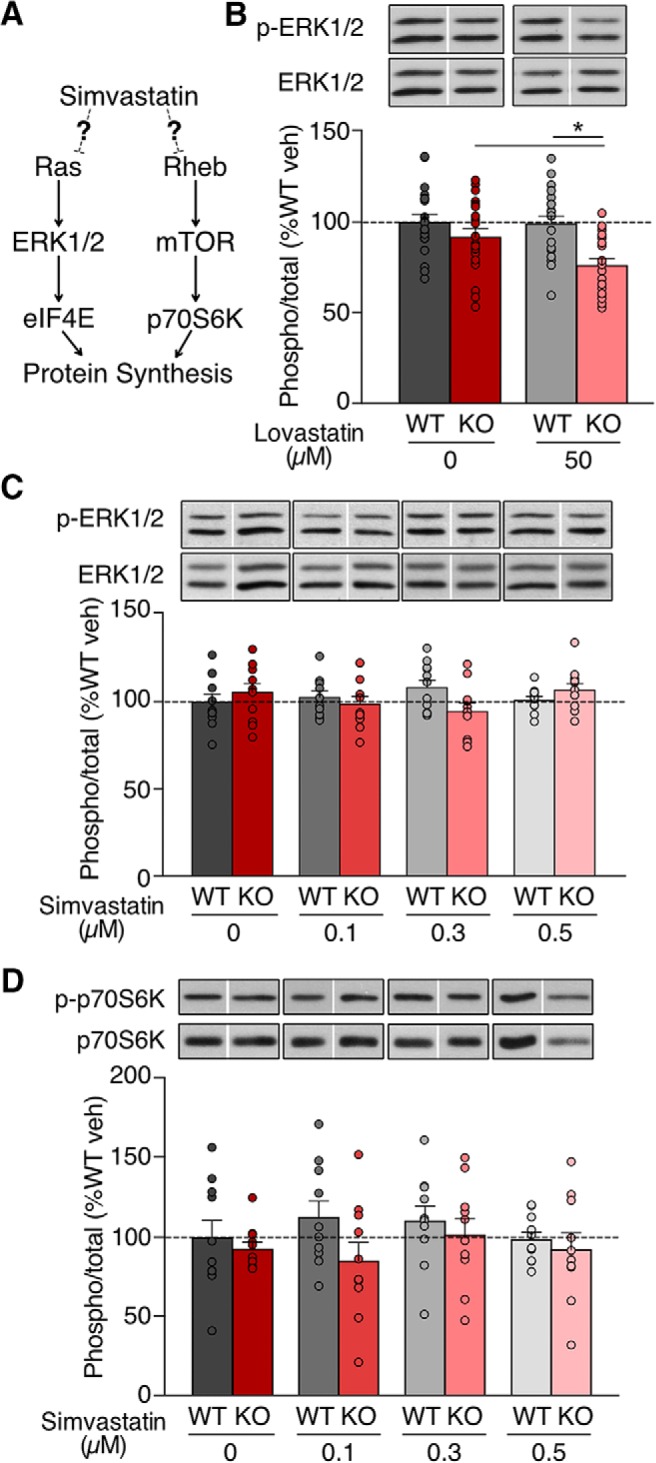
Simvastatin does not reduce ERK1/2 or mTORC1 activation in the Fmr1-/y hippocampus. A, Diagram shows the potential impact of simvastatin on Ras-ERK1/2 and Rheb-mTOR-signaling pathways. B, Fmr1-/y slices incubated with 50 µM lovastatin show a significant reduction in ERK1/2 phosphorylation (ANOVA genotype *p = 0.0146; Sidak’s KO veh vs KO lova *p = 0.0048; n = 19). C, Simvastatin treatment does not reduce ERK1/2 phosphorylation in Fmr1-/y or WT slices (ANOVA treatment p = 0.8761, genotype p = 0.7010; n = 11). D, Simvastatin treatment does not reduce phosphorylation of p70S6K in WT or Fmr1-/y slices (ANOVA treatment p = 0.6206, genotype p = 0.2860; n = 10). Representative bands were cropped from original blots as indicated by blank spaces. Original blots are shown in Extended Data Figure 2-1. Error bars = SEM. N = littermate pairs. Figure Contributions: Melania Muscas performed the experiments and analyzed the data.